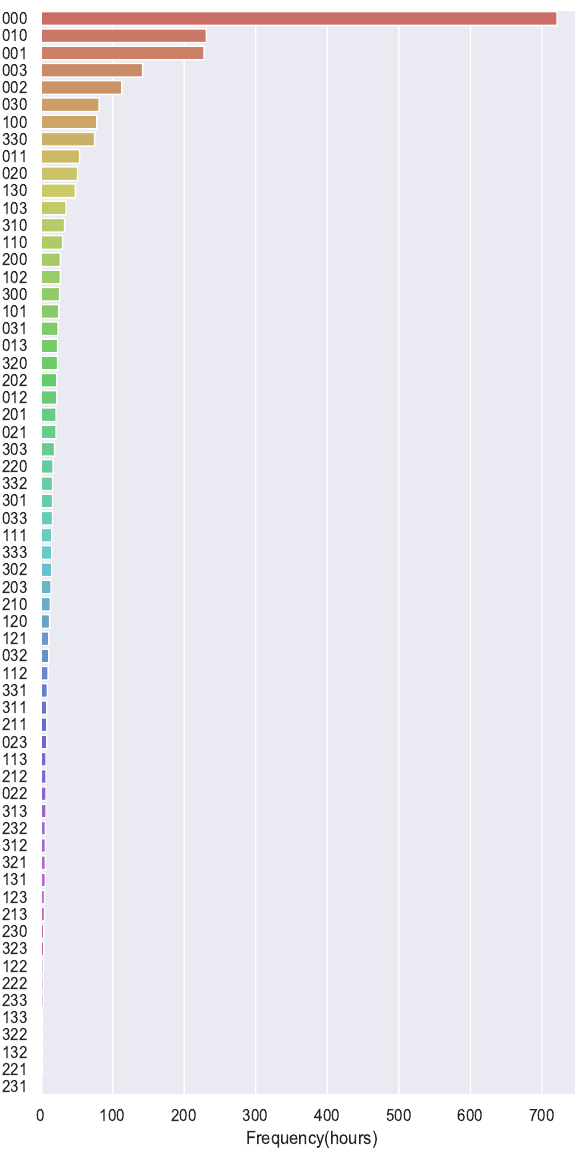
Figure 9. Frequency of EC glass combinations chosen by